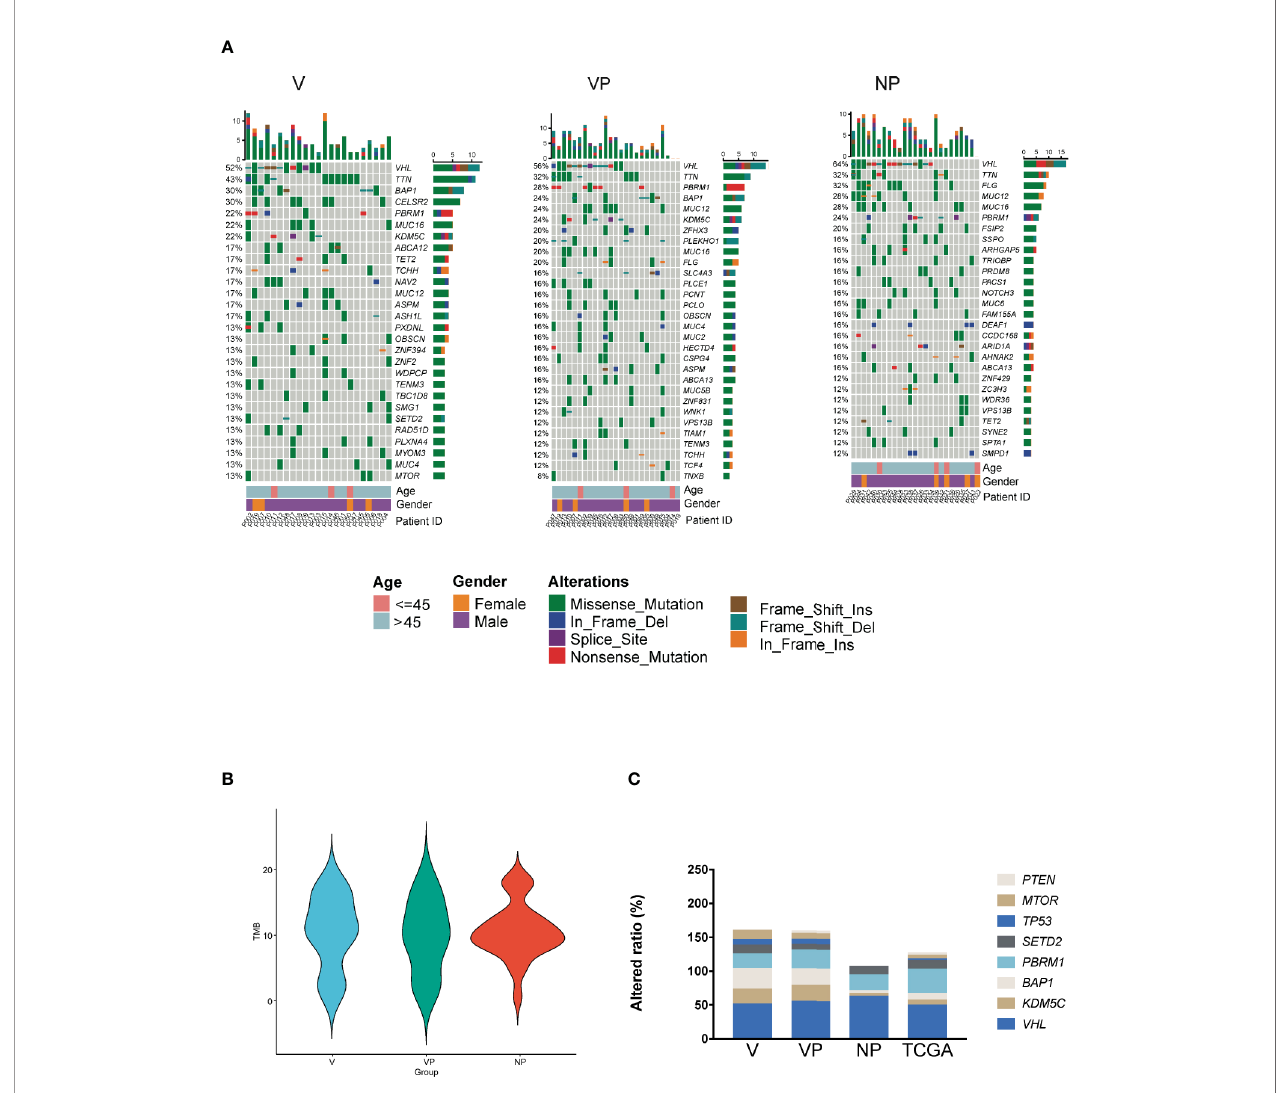
FIGURE 1 | Somatic mutation landscape of ccRCC with and without VTT. (A) Mutation landscape of the NP (n = 25), VP (n = 25), and V (n = 23) samples. The vertical histogram shows the number of different mutational types in each sample. The heat map shows the distribution of top genes across samples. The horizontal histogram shows the number of different mutational types in each gene. (B) The tumor mutation burden of the V, VP, and NP groups. (C) The frequency of mutations in driver genes of ccRCC in the three groups (V, VP, and NP) and in data obtained from TCGA. TCGA, The Cancer Genome Atlas; VTT, venous tumor thrombus; ccRCC, clear cell renal cell carcinoma; V, VTT; VP, matched primary tumor; NP, normal primary tumors without